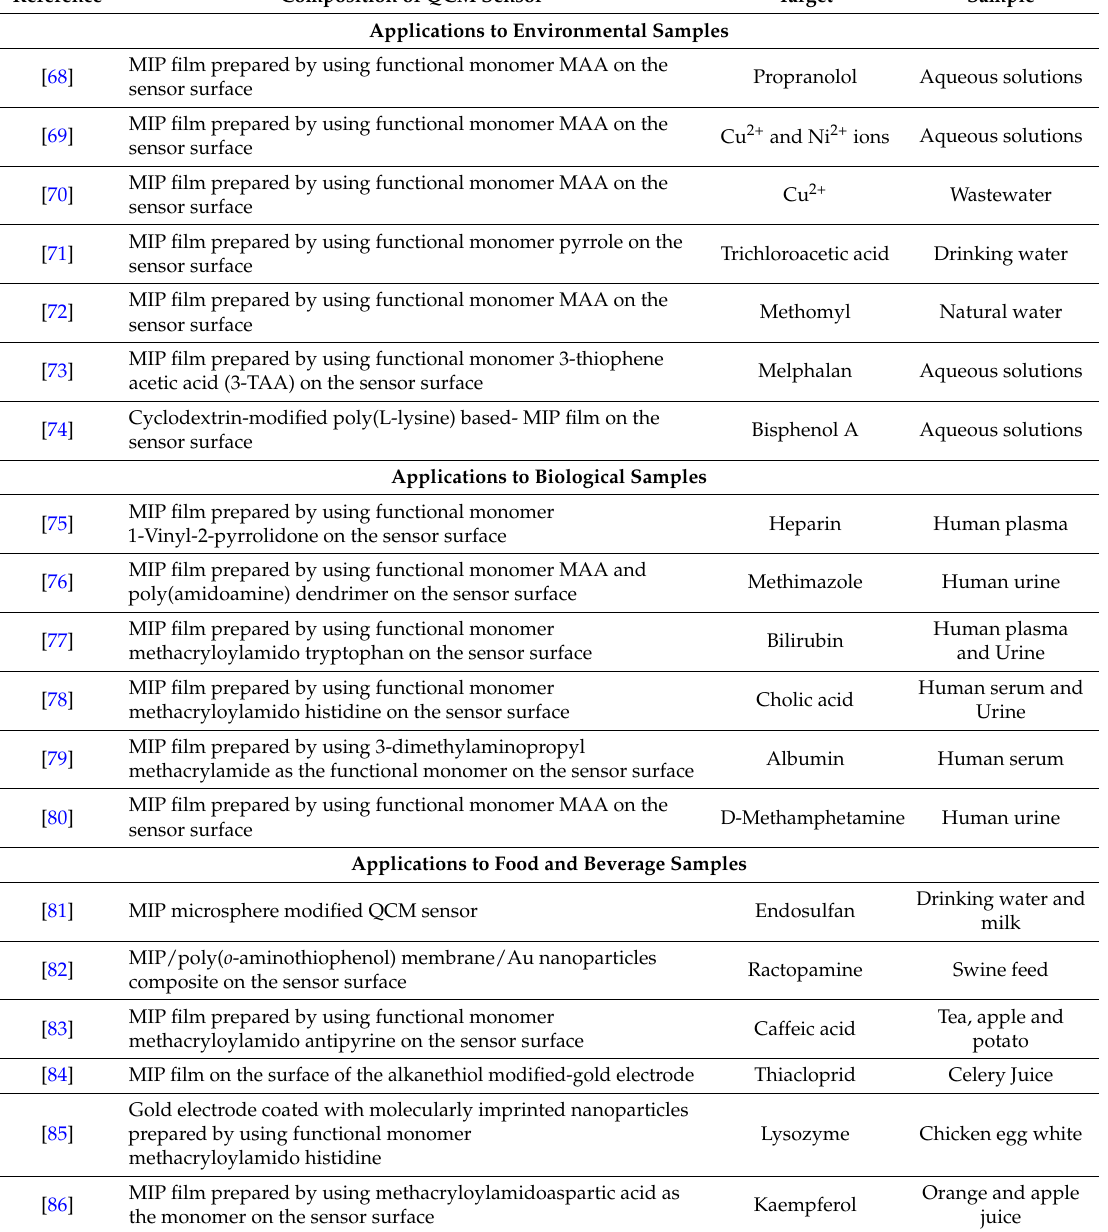
Table 1. Recent reported studies of MIP-based QCM sensor in different